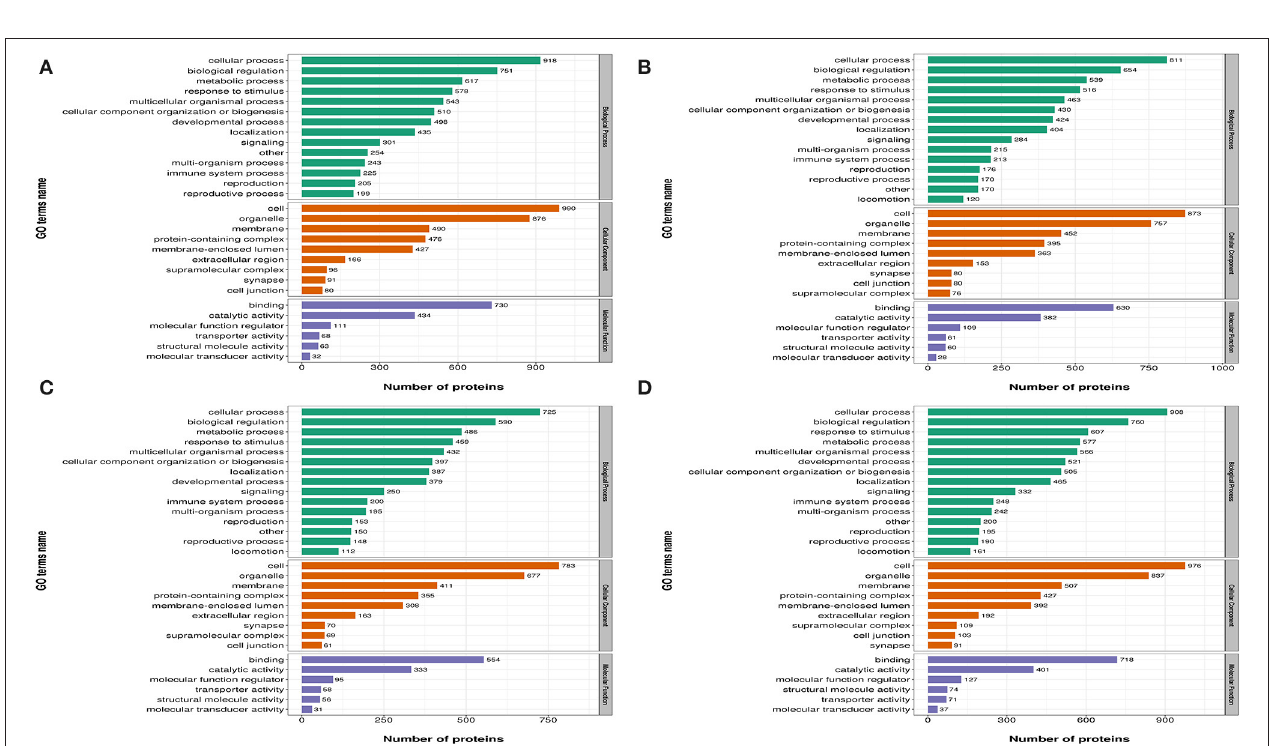
FIGURE 3 | Gene Ontology (GO) analysis of differently expressed proteins based on biological processes, cellular components, and molecular functions. (A) 7 dpi. (B) 14 dpi. (C) 21 dpi. (D) 28 dpi.